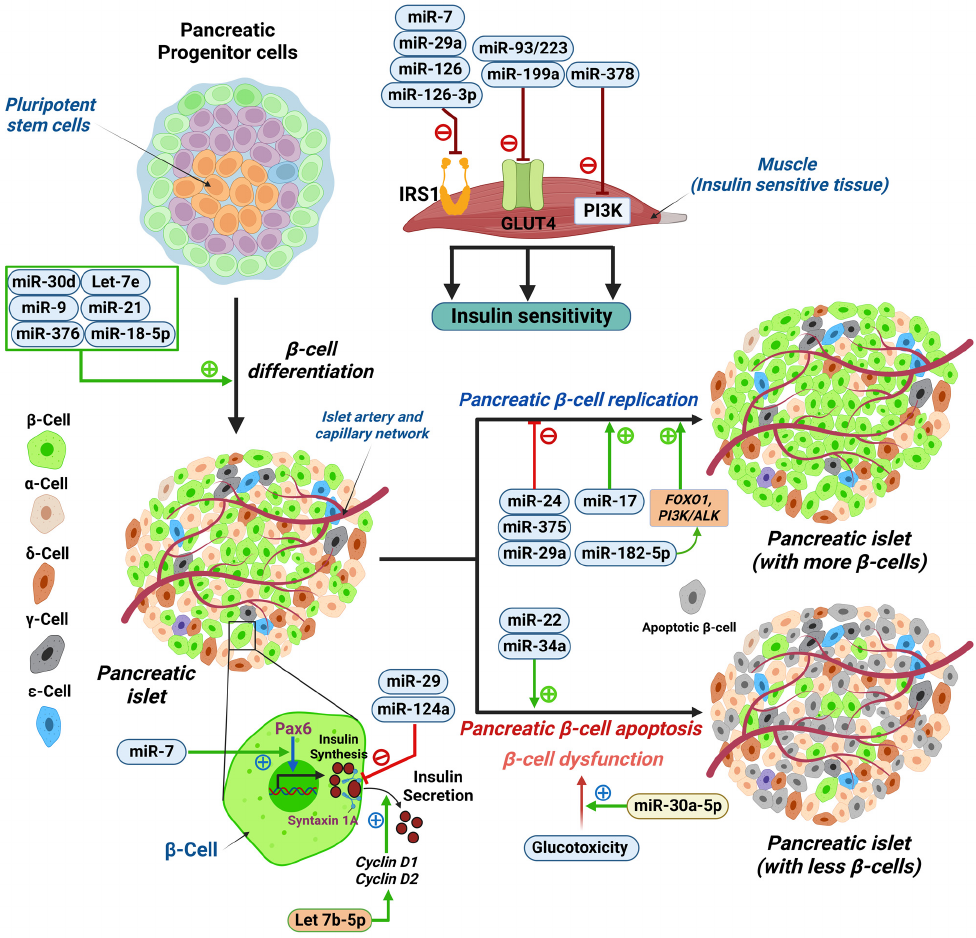
Figure 1. Schematic illustration showing micro RNAs (miRNAs) involved in pancreatic β -cell dif- ferentiation, function, and survival. miRNAs that regulate insulin action in insulin sensitive tissues (muscle, for example) are miR-7, miR-29a, miR-126, and miR-126-3p that negatively regulate IRS1; miR-93/223 and miR-199a that negatively regulate glucose transporter type 4 (GLUT4); and miR-378 that negatively regulates phosphoinositide 3-kinase (PI3K). miR-30d, let-7e, miR-9, miR-21, miR-376, and miR-182-5p positively regulate pancreatic β -cell differentiation from pancreatic progenitor cells. While miR-24, miR-375, and miR29a negatively regulate pancreatic β -cell replication, miR-17, and miR-182-5p (by activating the FOXO1, PI3K/ALK pathway) is a positive regulator. miR-22 and miR-34a induce pancreatic β -cell apoptosis. miR-30a-5p modulates the glucotoxicity induced β -cell dysfunction. miR-7 positively regulates Paired box protein (Pax-6) to enhance insulin synthesis in β -cells. Let-7b-5p positively regulates insulin secretion by modulating cyclin D1 and cyclin D2. miR-29 and miR-124a negatively regulate syntaxin 1A, which reduces insulin secretion from pan- creatic β -cells. Pancreatic islets contain insulin producing ( β -cells), glucagon producing ( α -cells), somatostatin producing ( δ -cells), pancreatic polypeptide producing ( (cid:134) -cells), and ghrelin producing ( (cid:130) -cells) endocrine cells. FOXO1, Forkhead box protein O1; PI3K, phosphoinositide 3-kinase; ALK, anaplastic lymphoma kinase. Illustration created using Biorender.com (with publication